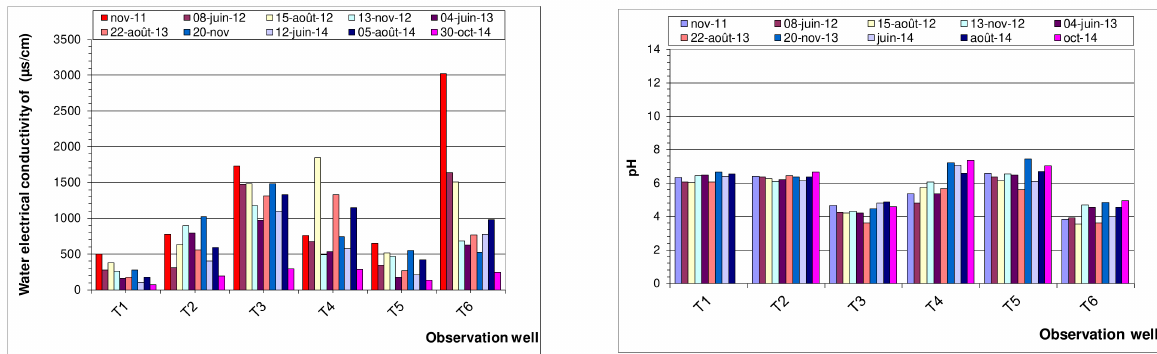
Figure 5. Electrical conductivity and pH in water samples from wells